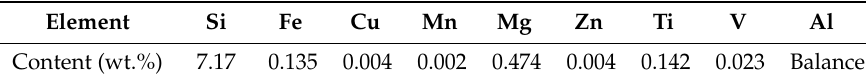
Table 1. Chemical compositions of research alloys (wt.%).